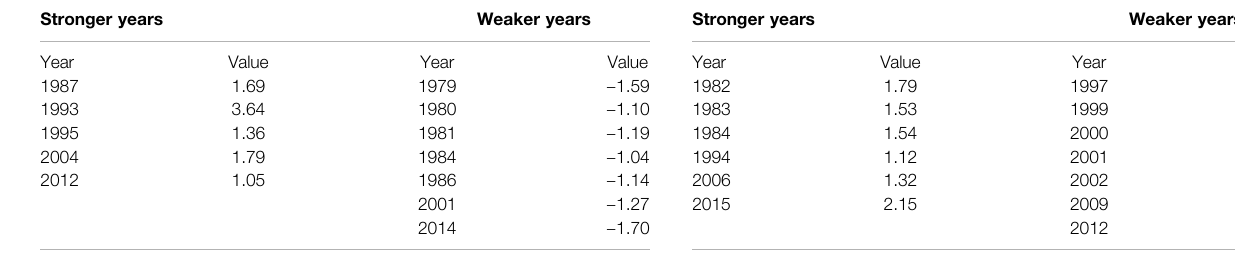
TABLE 2 | The stronger and weaker years in the EOF time series 2 and their corresponding time coef fi cients. Stronger years Weaker years Year